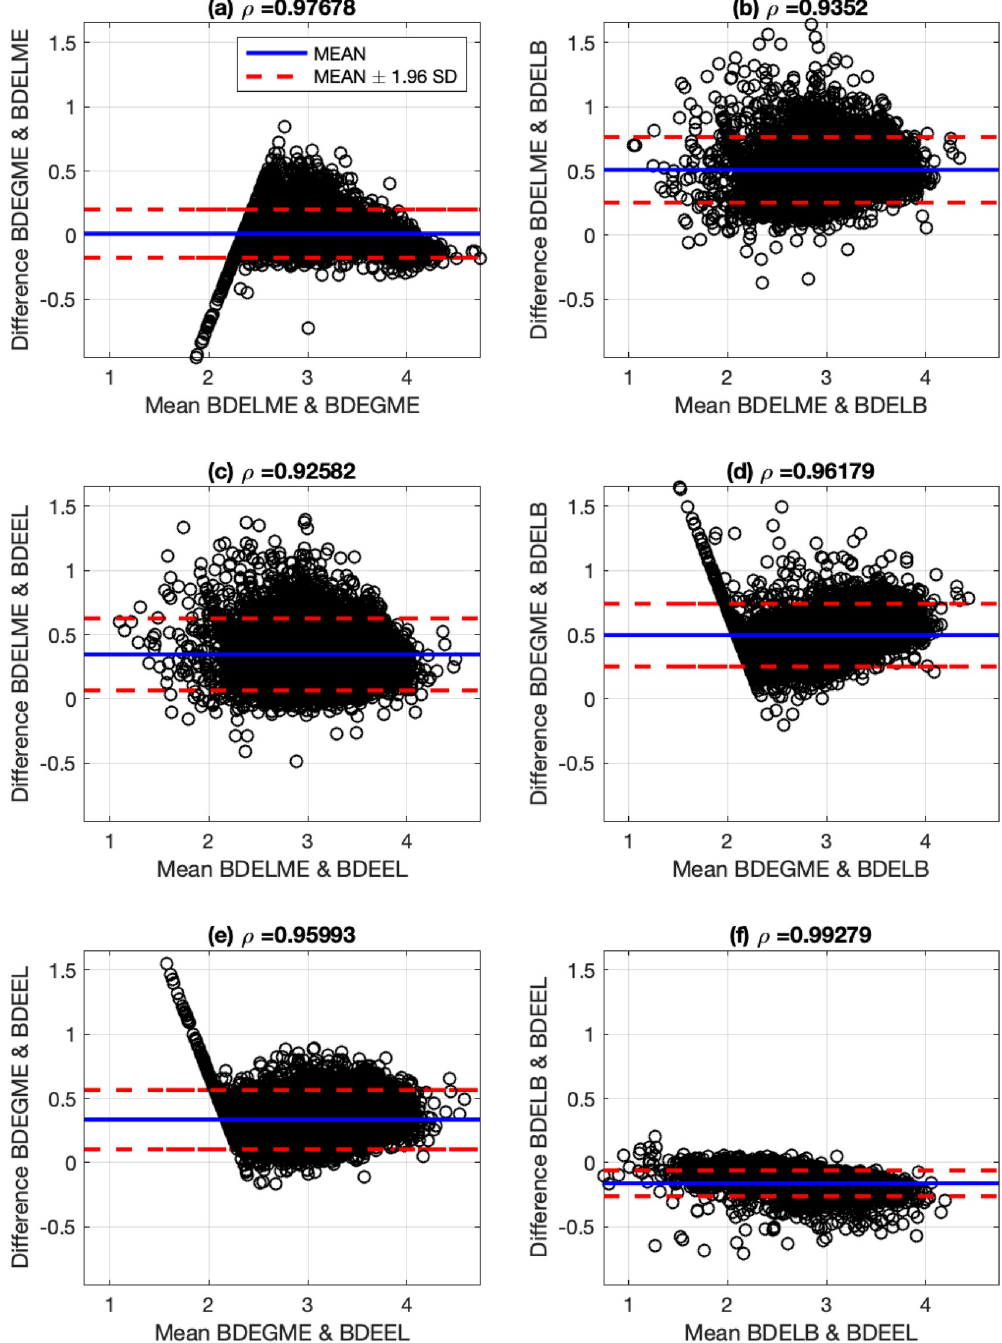
Fig 13. Bland-Altman plots for estimated average lifetimes for lesion sample No. 82 in 3rd spectral channel and correlation coefficients: (a) BDELME vs BDEGME, (b) BDELME vs BDELB, (c) BDELME vs BDEEL, (d) BDEGME vs BDELB, (e) BDEGME vs BDEEL, and (f) BDELB vs BDEEL.